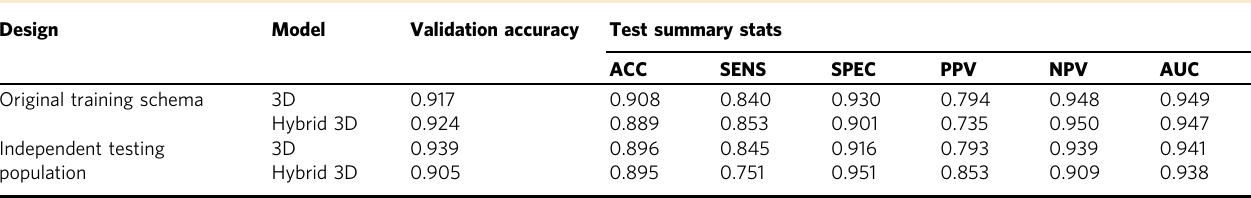
Fig. 1 3D classi fi cation work fl ow. All CT images under lung segmentation for localization to chest cavity region. Following cropping to lung region, two methods were considered for differentiation of COVID-19 from other clinical entities. a Full 3D Model resampled the cropped lung region of CT to a fi xed size (192 × 192 × 64 voxels) for input to algorithm. b Hybrid CT resampled the cropped lung region of CT to fi xed resolution (1mm × 1mm × 5mm) and sampled multiple 3D regions (192 × 192 × 32) for input to algorithm. At training, 6 regions/patient were used. At inference 15 regions/patient were used and results were averaged to produce fi nal probability of COVID-19. Table 2 Performance of 3D and hybrid 3D classi fi cation models for two experimental conditions.